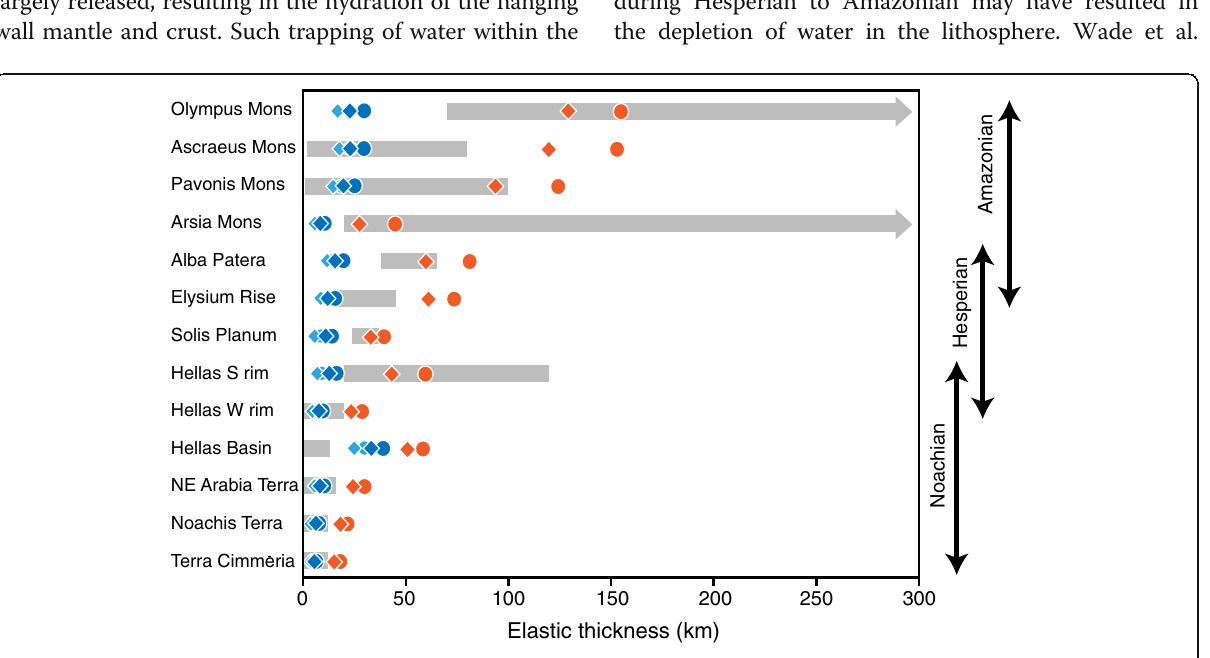
Fig. 7 Calculated elastic thickness at various locations compared with observations. Red, blue, and light blue symbols represent results calculated for dry, wet, and extremely wet conditions, respectively. The influence of strain-rate on the calculations is indicated by diamond and circle symbols, which represent calculations performed at 10 − 19 s − 1 and 10 − 16 s − 1 , respectively. Grey bars indicate the estimated elastic thickness from gravity and topography data collected by the Mars Global Surveyor (McGovern et al. 2004). The age of each location is shown in the right-hand